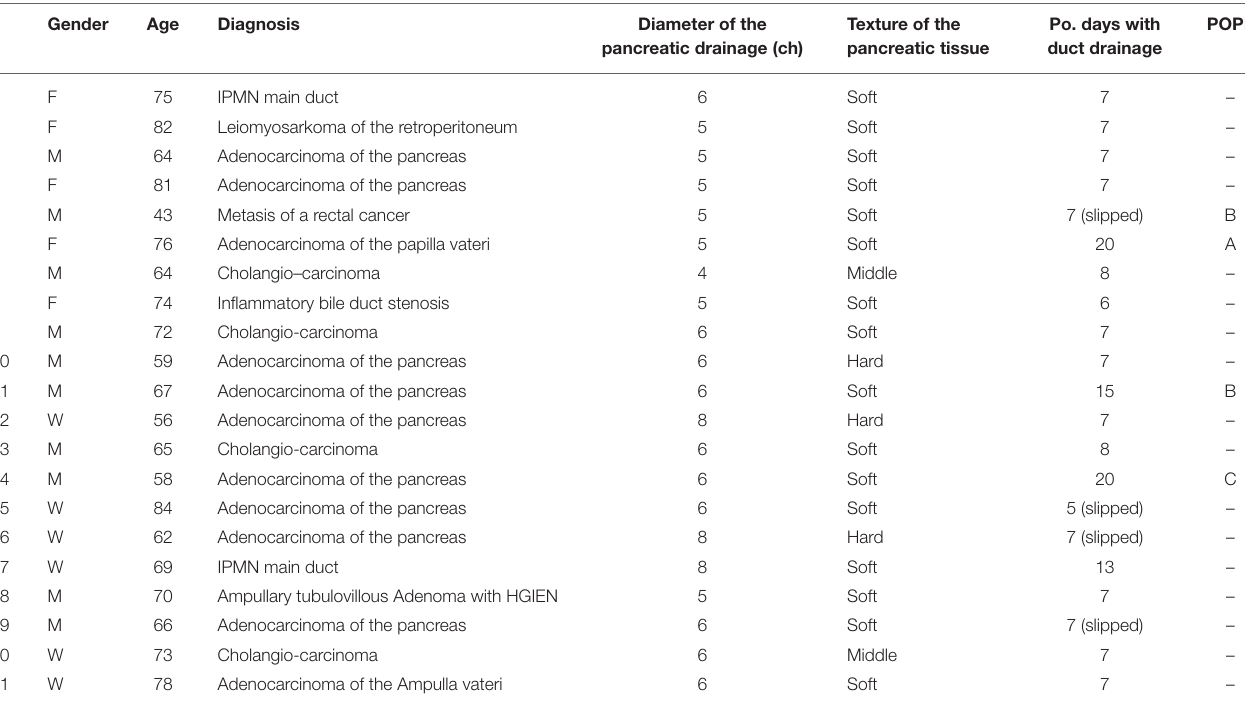
TABLE 1 | Patient demographics, intraoperative data and POPF